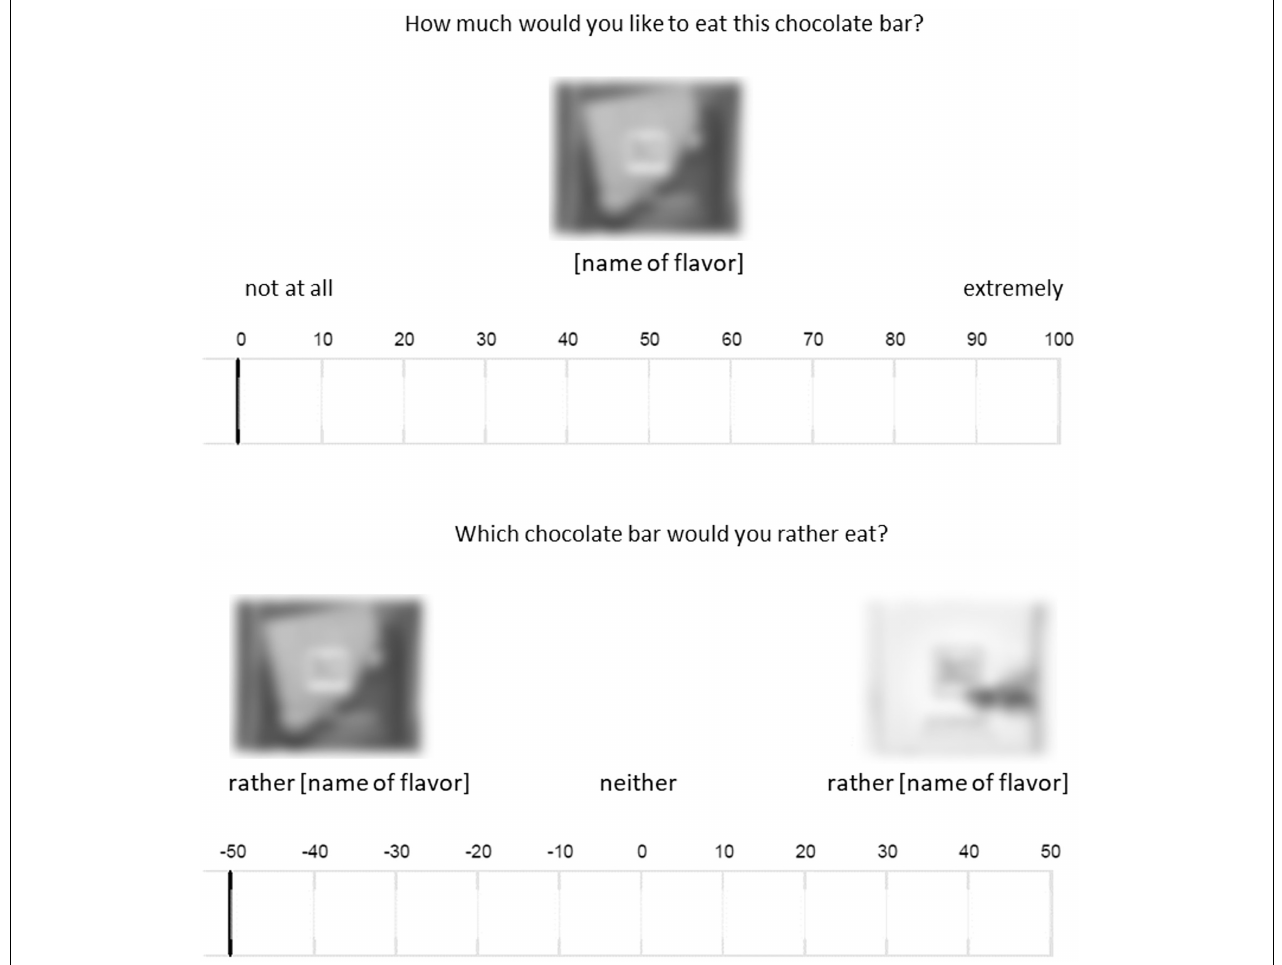
FIGURE 1 | Example of a rating trial in the sequential rating condition (top) and the simultaneous rating condition (bottom) in Study